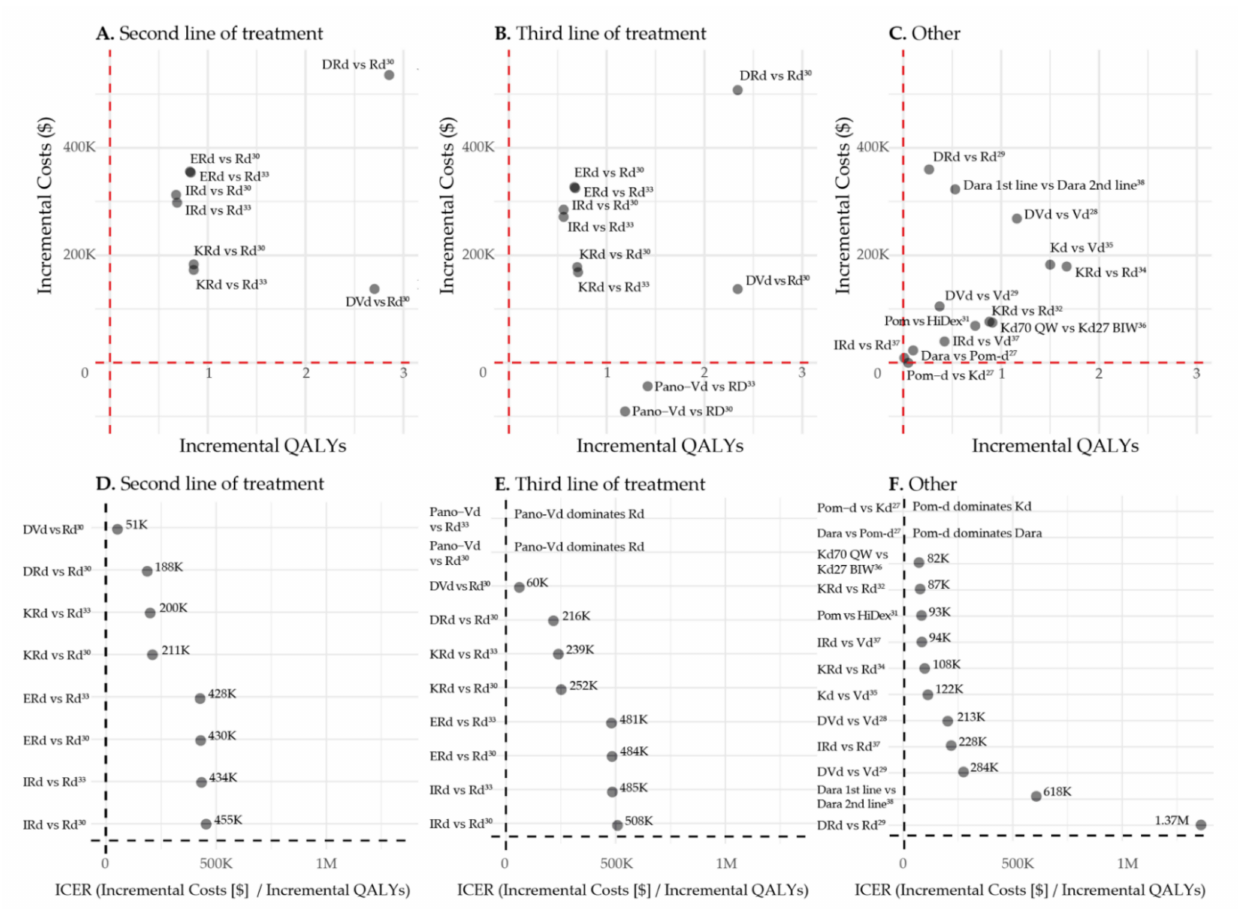
Figure 2. Incremental Costs, incremental QALYs and ICERs. Abbreviations: Dara: Daratumumab (monotherapy or in combination with backbone therapy), Pom: Pomalidomide monotherapy, Pom-d: Pomalidomide-dexamethasone, Kd: Carfilzomib-dexamethasone, DVd: Daratumumab-bortezomib-dexamethasone, Vd: Bortezomib-dexamethasone, DRd: Daratumumab-lenalidomide-dexamethasone, Rd: Lenalidomide-dexamethasone, KRd: Carfilzomib-lenalidomide- dexamethasone, Erd: Elotuzumab-lenalidomide-dexamethasone, Ird: Ixazomib-lenalidomide-dexamethasone, Pano-Vd: Panobinostat-bortezomib-dexamethasone, HiDex: High dose dexamethasone monotherapy, Kd70 QW: Kd 70 mg/m 2 weekly, Kd27 BIW: Kd 27 mg/m 2 twice per